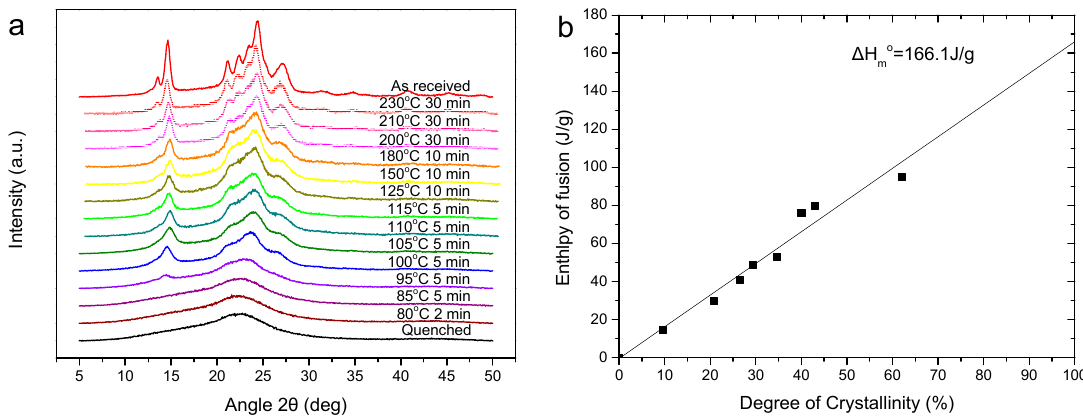
Figure 6. ( a ) Wide-angle X-ray di ff raction (WAXD) patterns for the PEV specimens after annealing at the indicated conditions and ( b ) enthalpy of fusion vs degree of crystallinity plot.